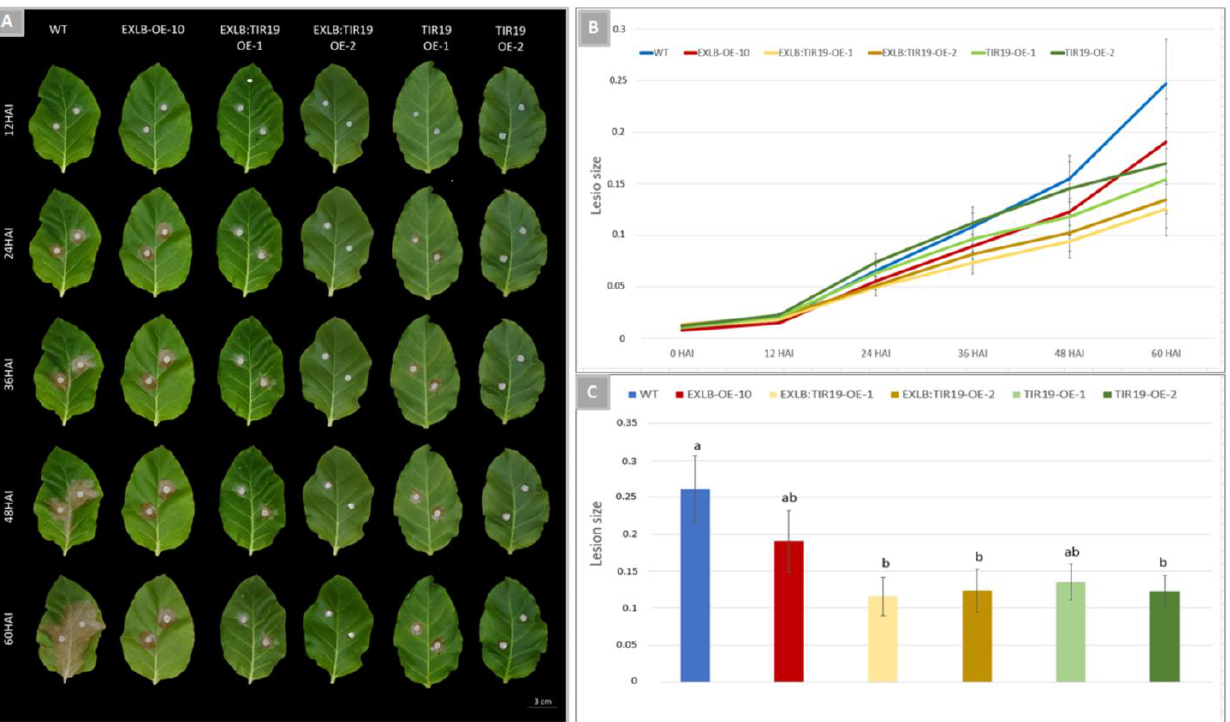
Figure 6. Sclerotinia sclerotiorum infection of detached tobacco leaves. ( A ) Lesion areas in leaves of